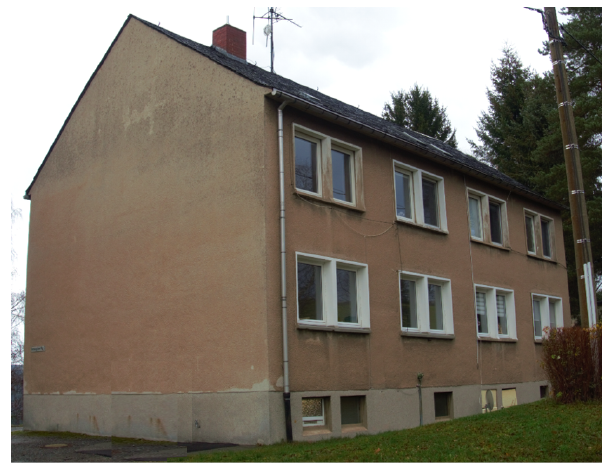
Figure 1. West-side view of the field trial building.